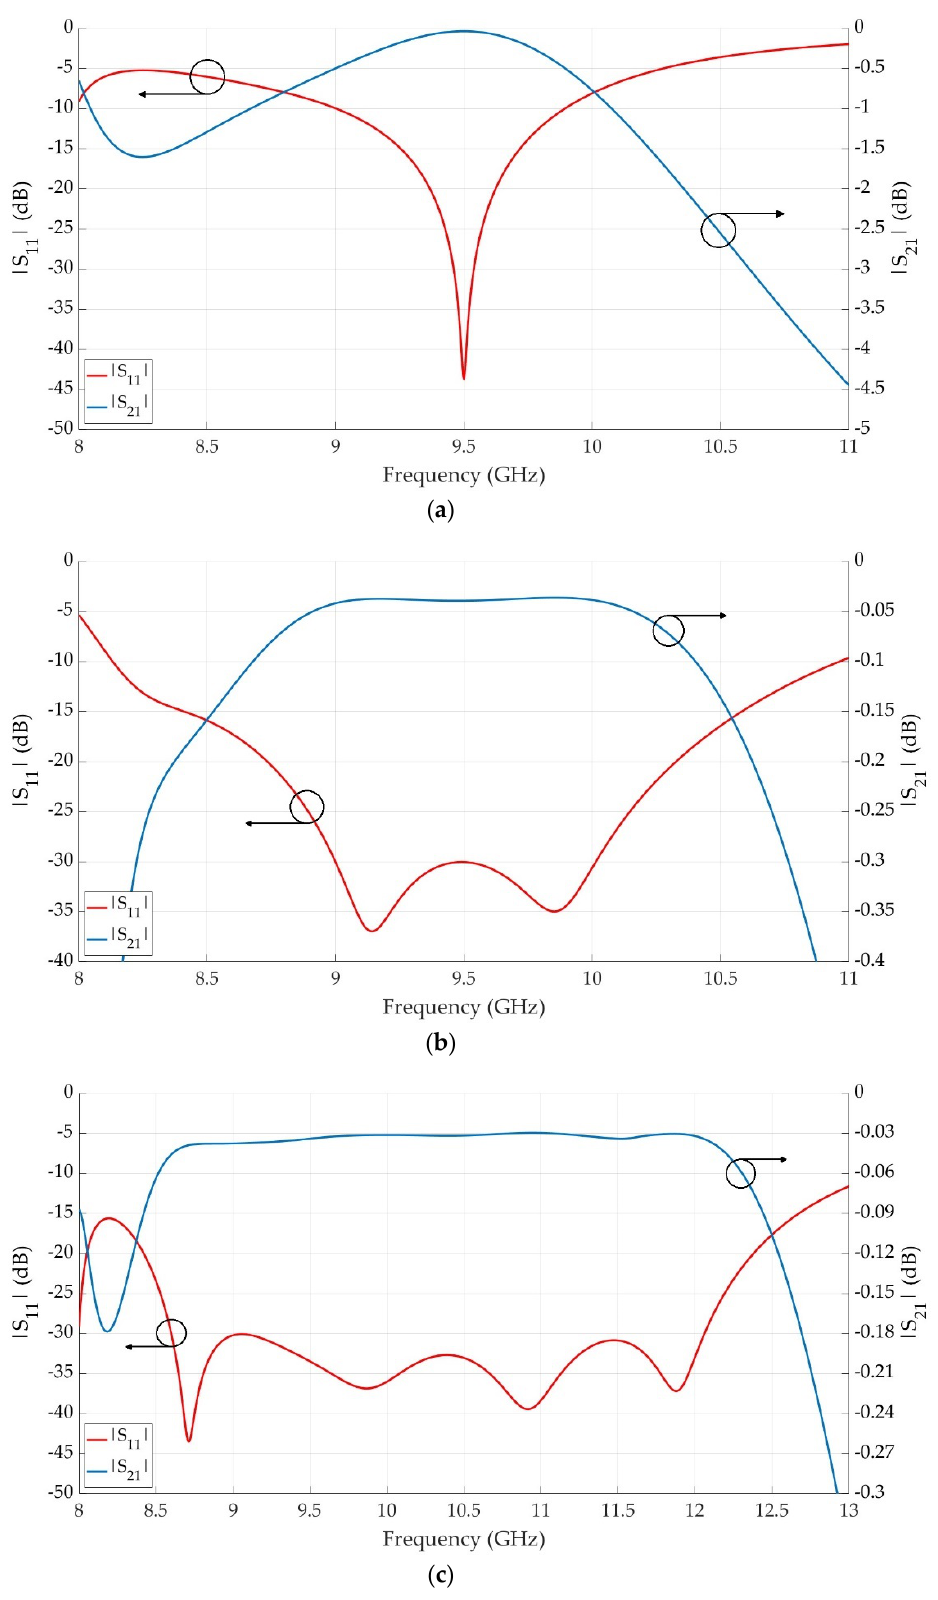
Figure 5. Coaxial-to-GGW transitions scattering parameters. ( a ) NB. ( b ) IB. ( c ) WB.